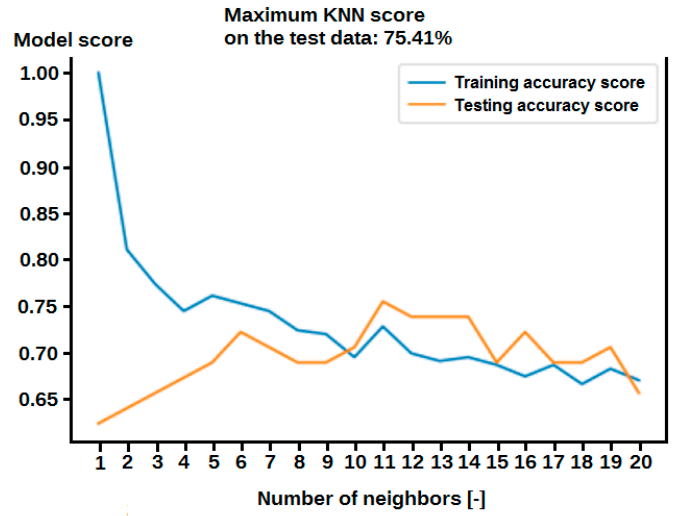
Figure 8. Training accuracy scores and testing accuracy scores for the KNN model.